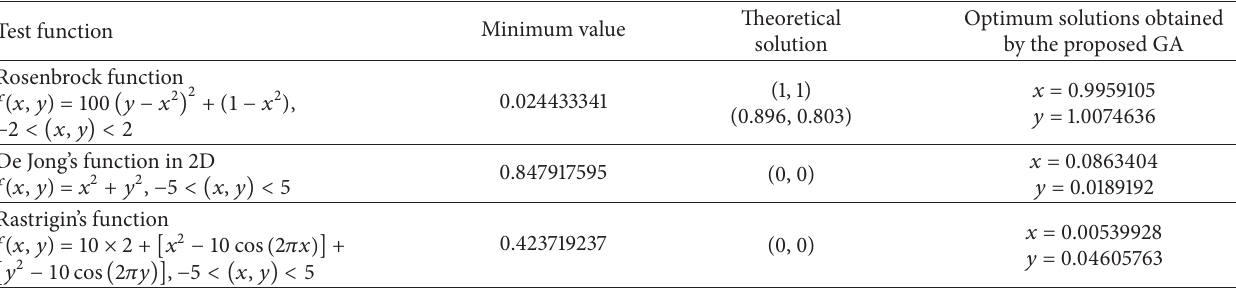
Table 2: Optimum solutions obtained by the proposed GA.